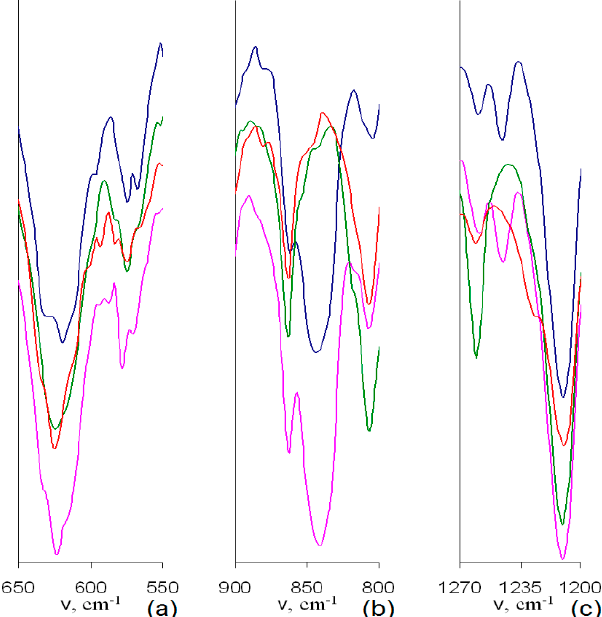
Figure 4. Normalized IR spectra of PMP-Br (blue line), samples 1 (pink line), 2 (green line) and 3 (red line) in the range of 650–550 cm − 1 ( a ), 900–800 cm − 1 ( b ) and 1270–1200 cm − 1 ( c ).